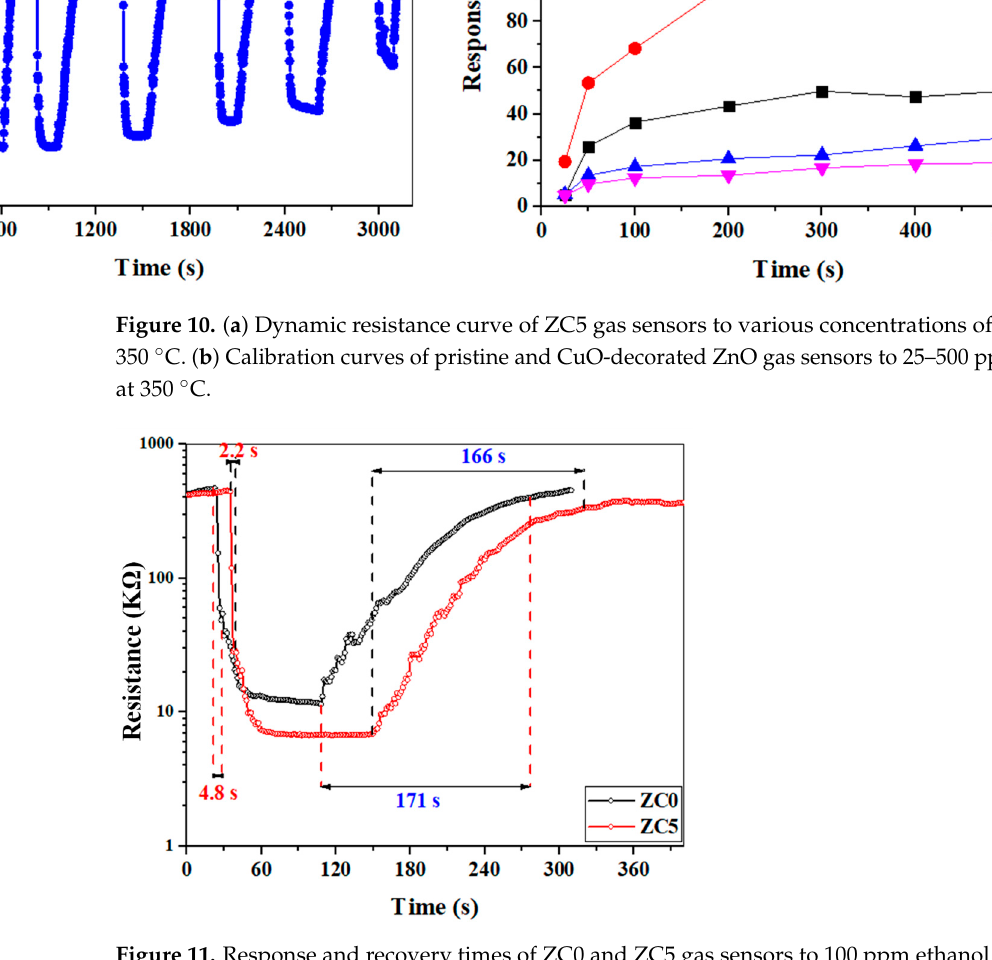
Figure 11. Response and recovery times of ZC0 and ZC5 gas sensors to 100 ppm ethanol at 350 ◦